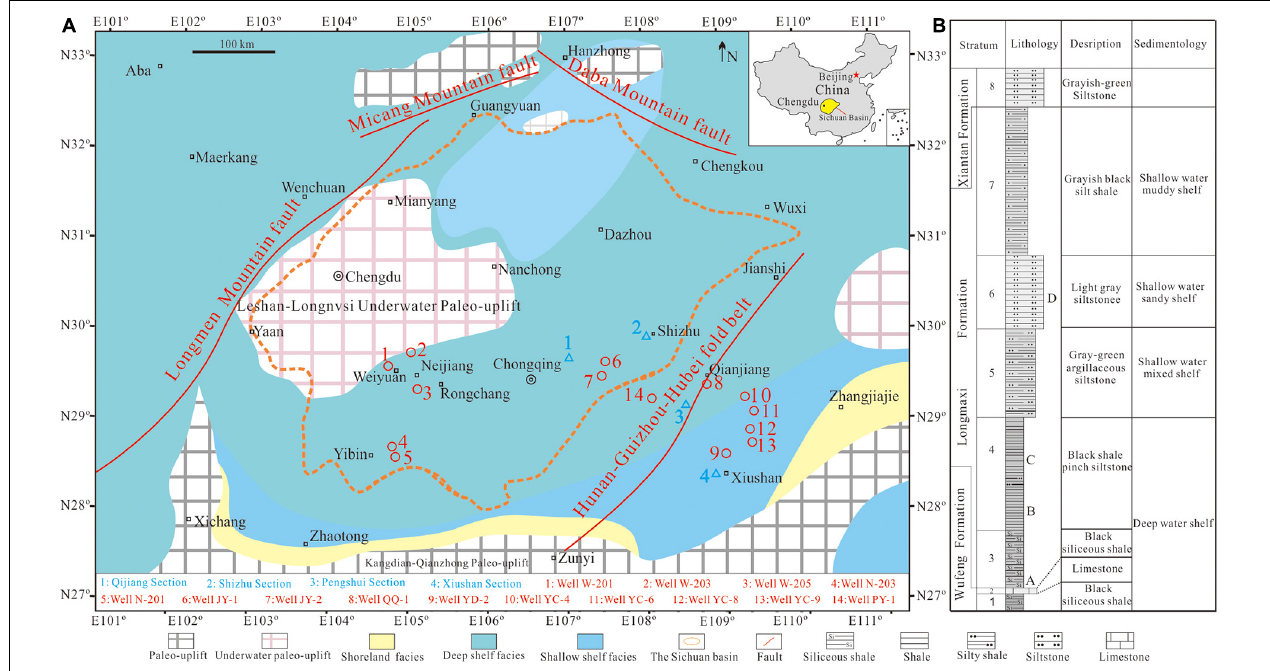
FIGURE 1 | A map (A) showing sedimentary characteristics and sampling locations of the Sichuan Basin (the inset map shows the basin location within China) (modified after Mou et al. (2011)). (B) The stratigraphic characteristics of the Longmaxi Formation in Xiushan section.